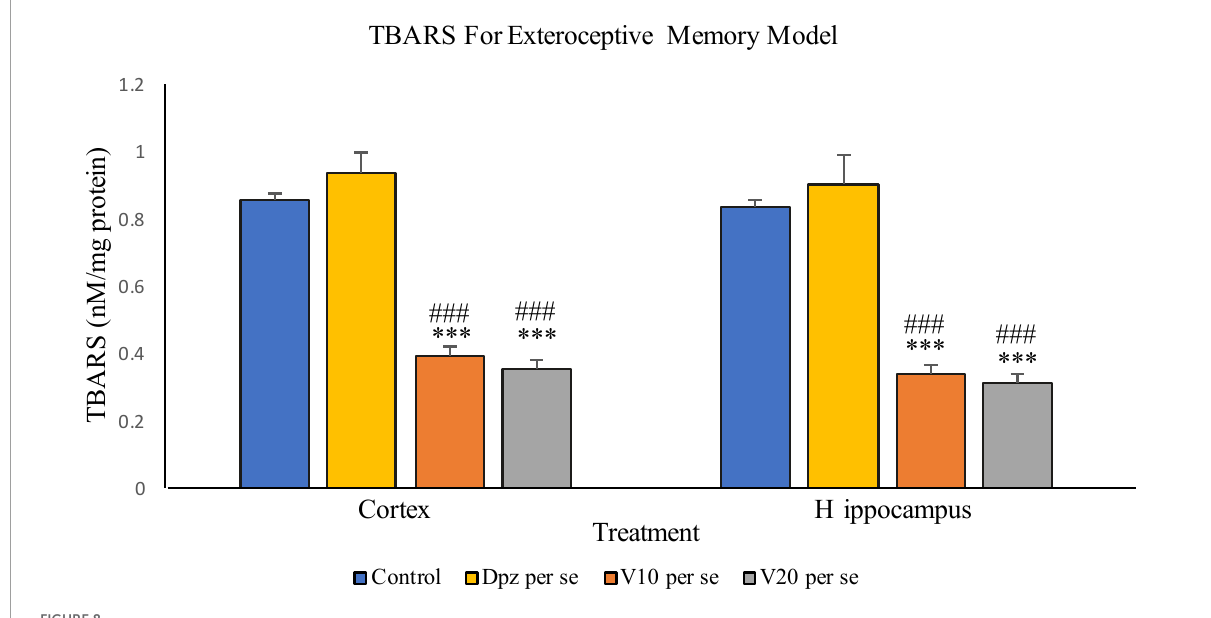
FIGURE8 Effect of vanillin and other treatments on TBARS. Data are expressed as mean ± SEM. “***” denotes P < 0.001 with respect to the control group. “###” denotes P < 0.001 with respect to the standard treatment group.